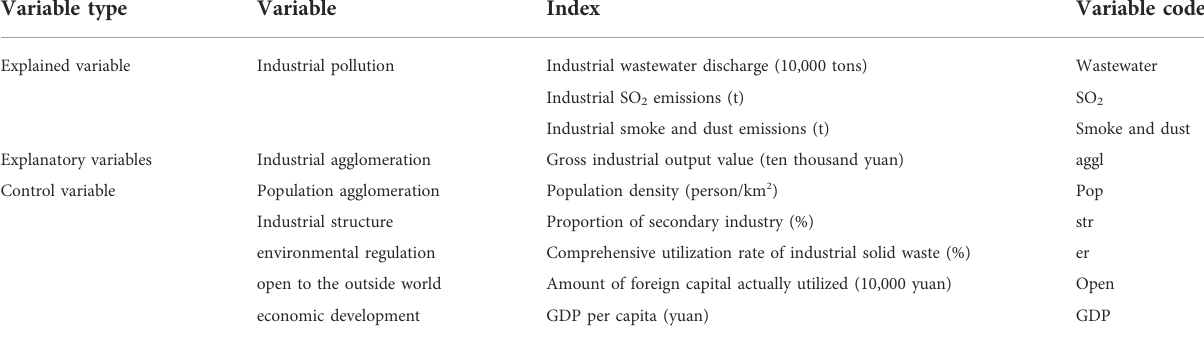
TABLE 2 De fi nition and explanation of